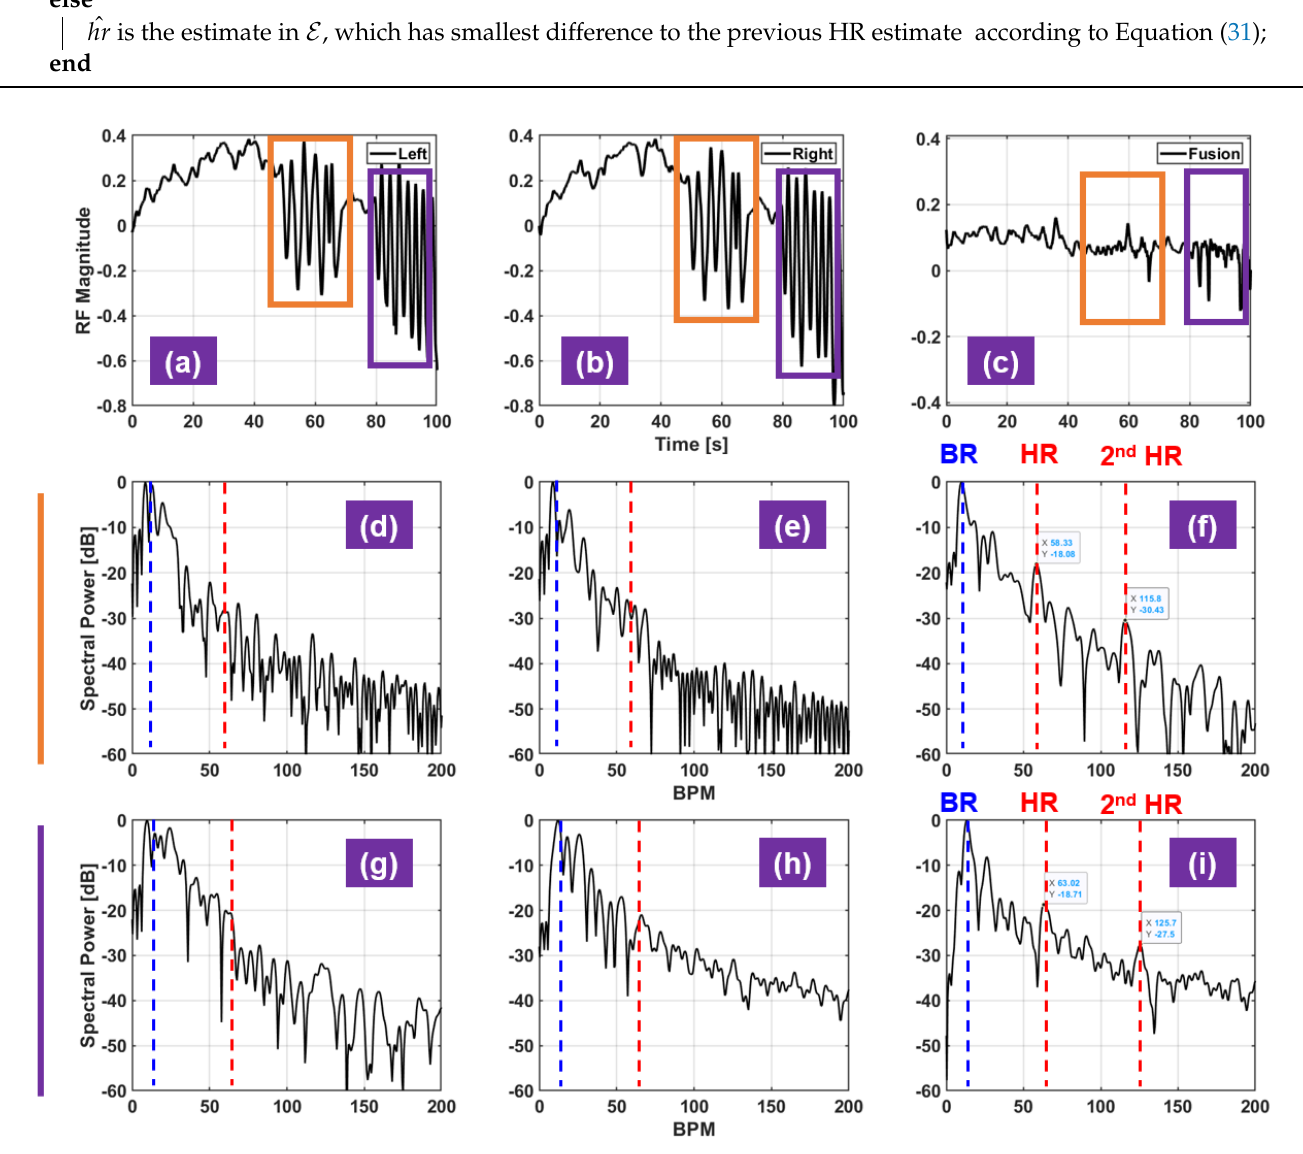
Figure 5. Heart-rate (HR) and breathing rate (BR) recovery in the presence of BFMs using RF fusion technique. From 45 to 72-s and 80 to 100 s, the human subject in free-style sitting position was instructed to move back and forth constantly. ( a , b ) represent the RF signals from the sensor pointing to the left side of the chest and to the right side of the chest; ( c ) represents the differential RF signal; while ( d – f ) show the corresponding vital-sign spectra from complex baseband signals, before and after motion cancellation, using 20-s of data from the highlighted time interval in ( a – c ) from 45 to 72-s; ( g – i ) show the corresponding vital-sign spectra from complex baseband signals, before and after motion cancellation, using 20-s of data from the highlighted time interval in ( a – c ) from 78 to